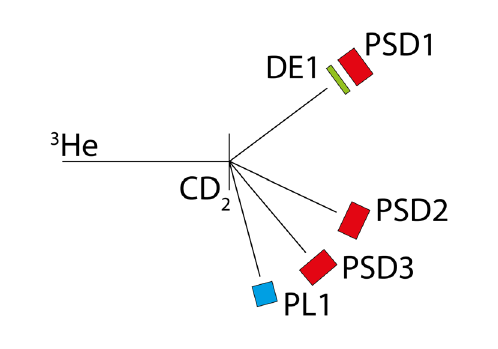
Figure 2. Experimental set-up adopted in the present